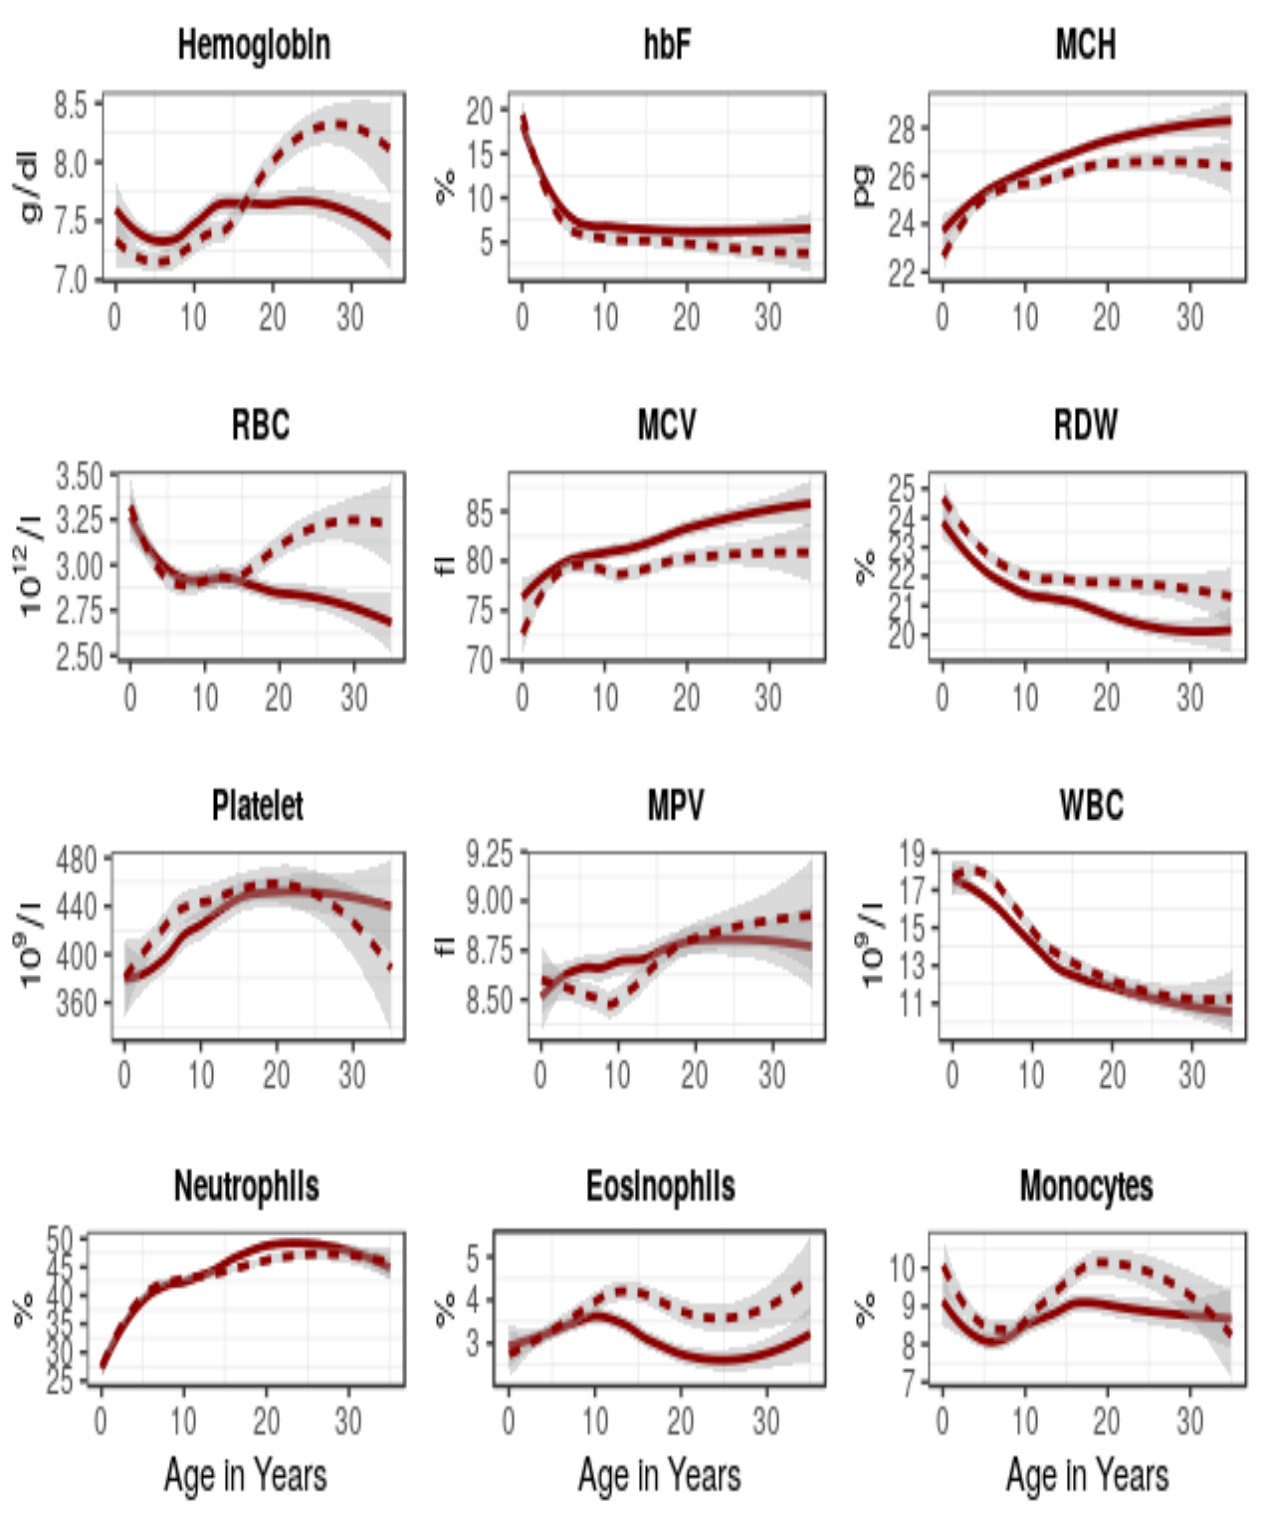
Figure 1. Smoothed mean curves for selected hematological parameters by sex. Solid lines denote the mean values for females and dashed lines denote the mean values for males.